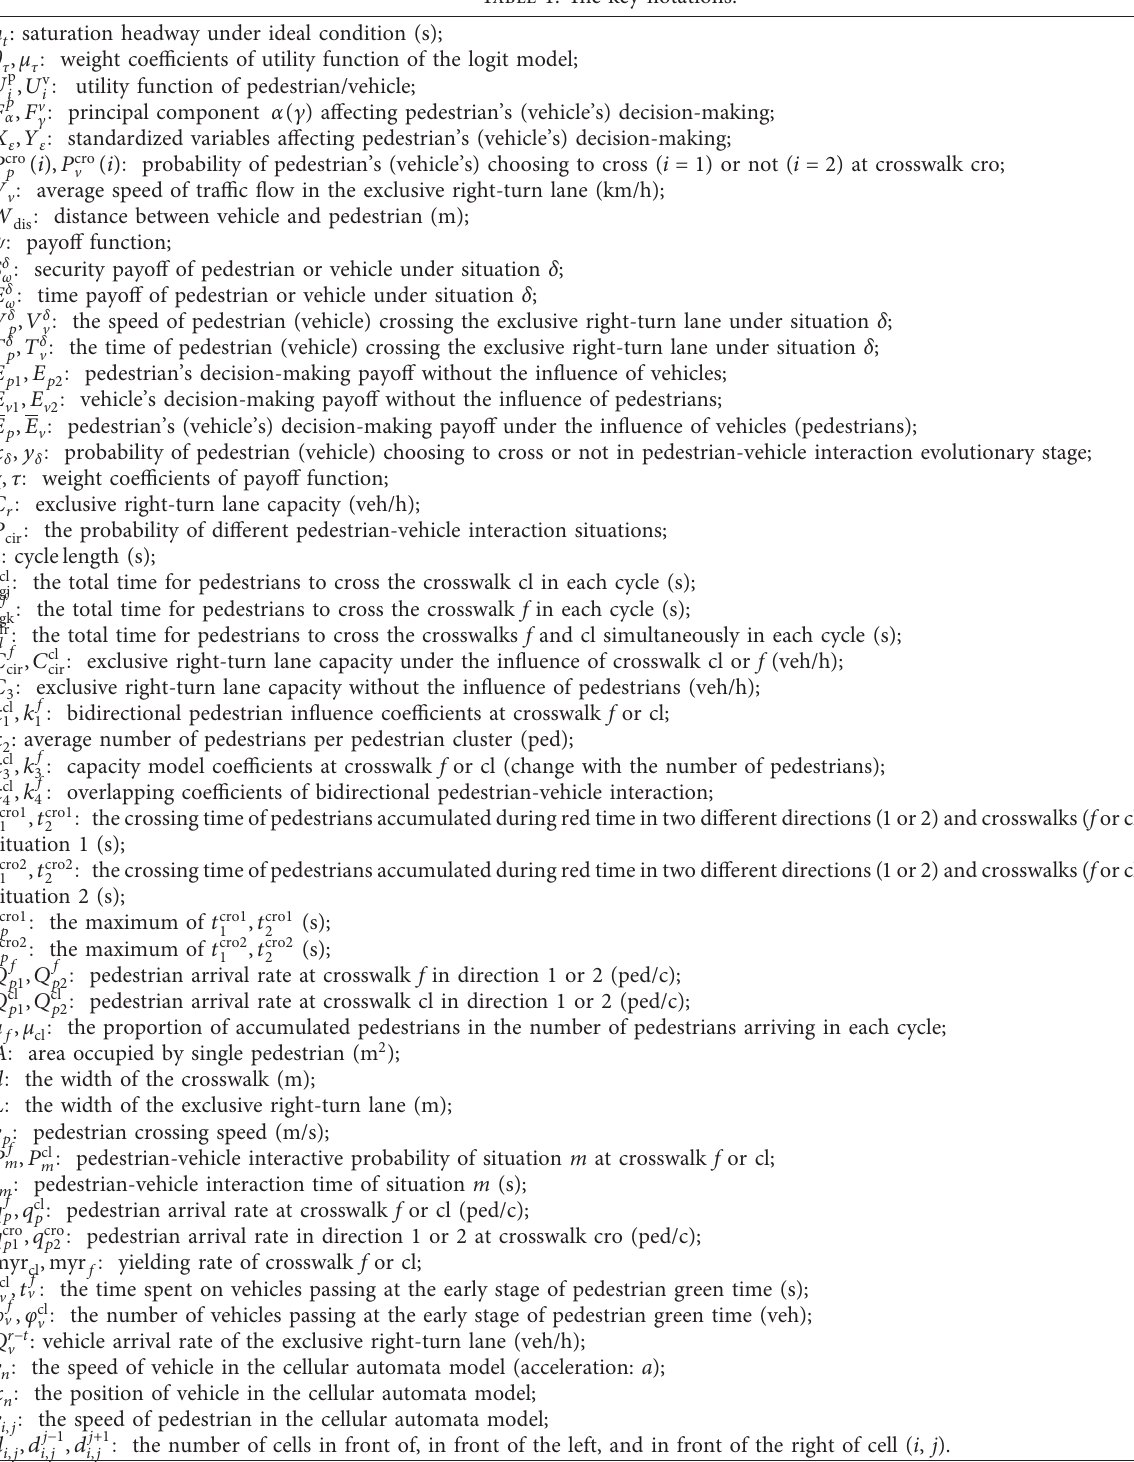
Table 1: The key